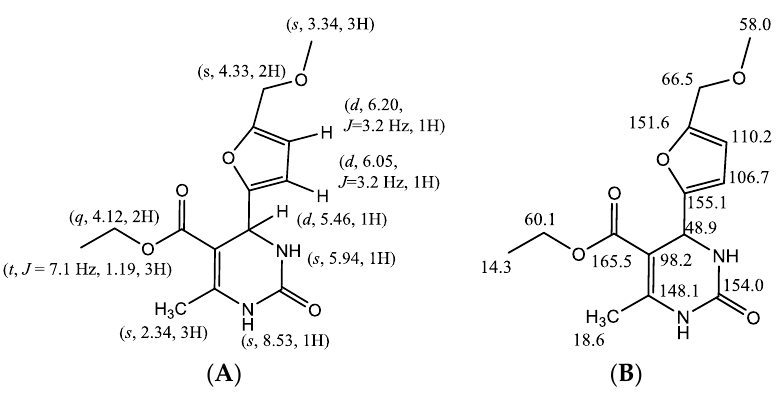
Figure 2. 1 H- ( A ) and 13 C- ( B ) NMR chemical shifts (CDCl 3 ) of the title compound.